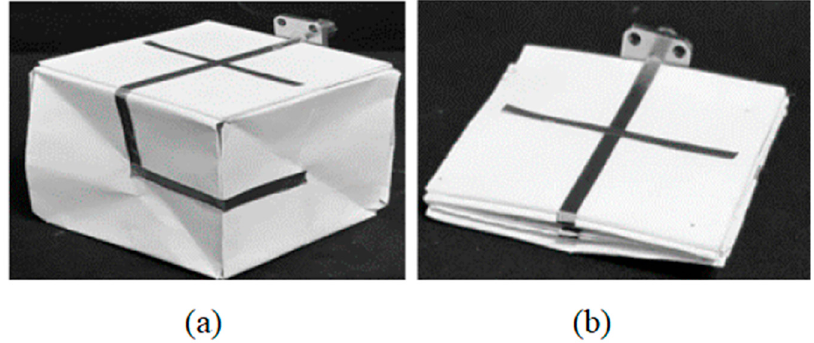
Figure 3. The frequency reconfigurable antenna based on changing the antenna shape (Origami Magic Cube): ( a ) unfolded; ( b ) folded [74].